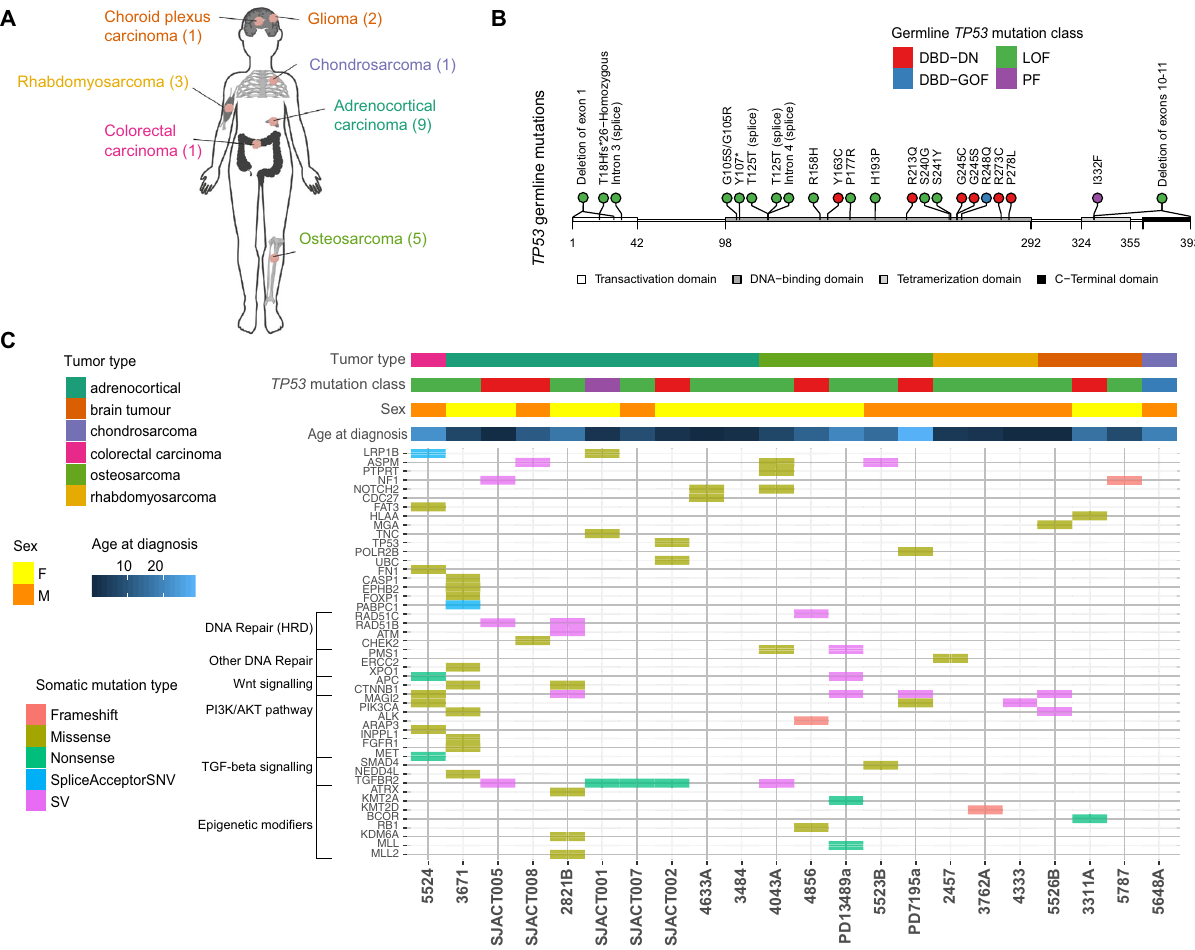
Fig. 1 | Themutationallandscape of TP53 -germline mutant childhood tumors. A TP53 -germlinemutanttumorsincludedinstudy.(#)indicatesnumberoftumors of each tumor type. B Location of germline mutations in TP53 gene, colored by functional impact. DBD-DN DNA binding domain-dominant negative, DBD-GOF